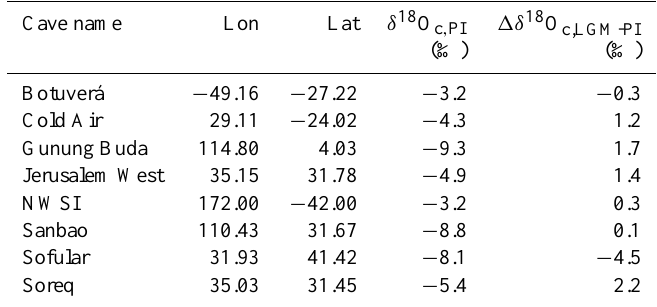
Table 2. Selected speleothem sites, reported PI and LGM values of δ 18 O c in calcite, and the calculated LGM-PI (cid:49)δ 18 O c,LGM-PI change. All values have been taken from a compilation by Shah et al. (2013) and represent 1000 year averaged δ 18 O c values for both the LGM (defined here as the period from 19000 to 22000 years BP) and the most recent 1000 years BP (used as an estimate for δ 18 O c , PI ). For Botuverá Cave, Gunung Buda National Park, and Sanbao Cave, mean values of several reported speleothem records have been calculated. All δ 18 O c values refer to the PDB